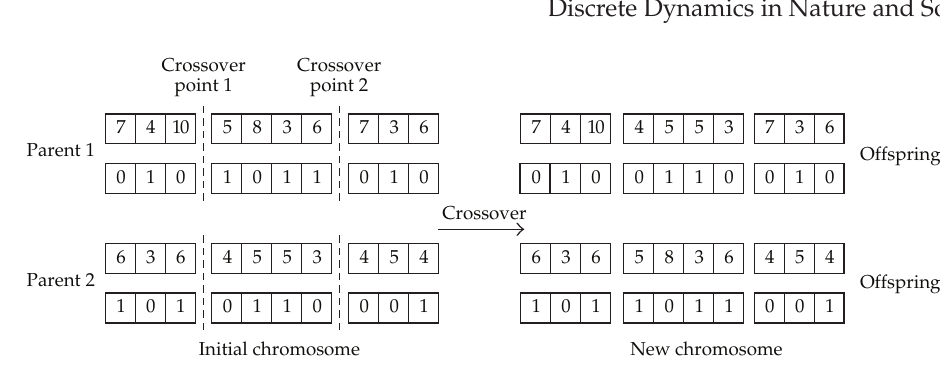
Figure 4: The illustration of two-layer crossover